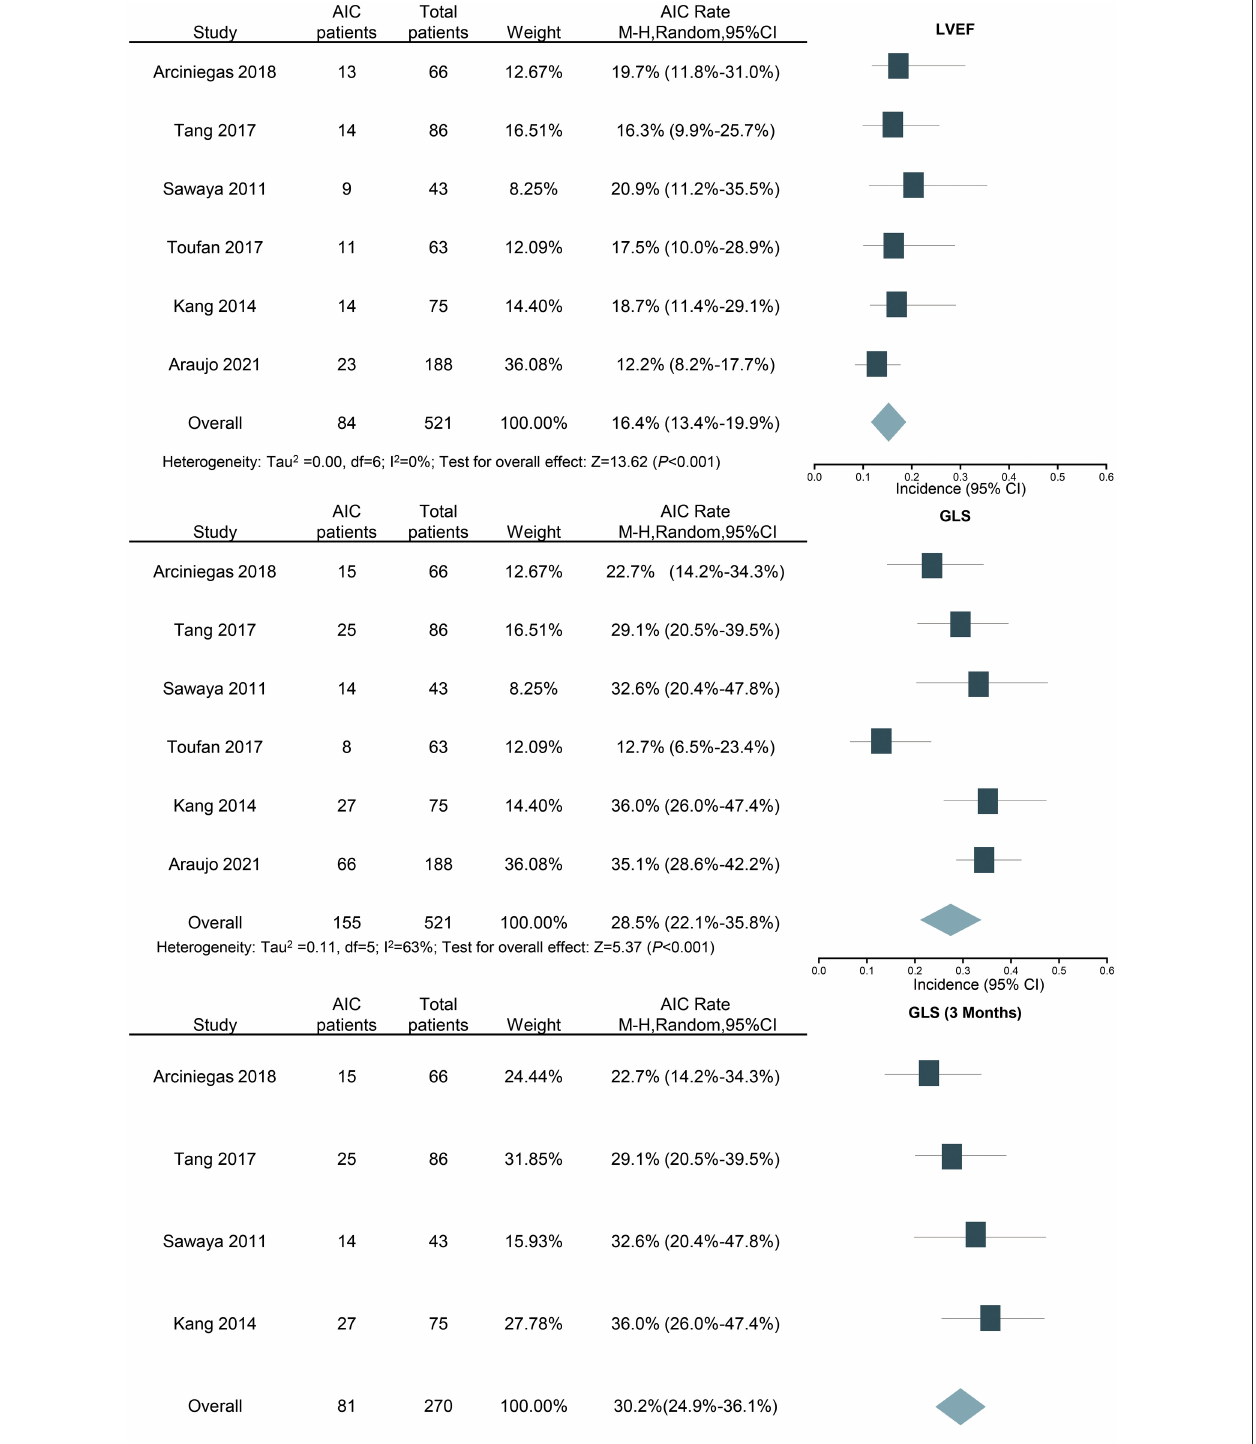
Frontiers in Cardiovascular Medicine |